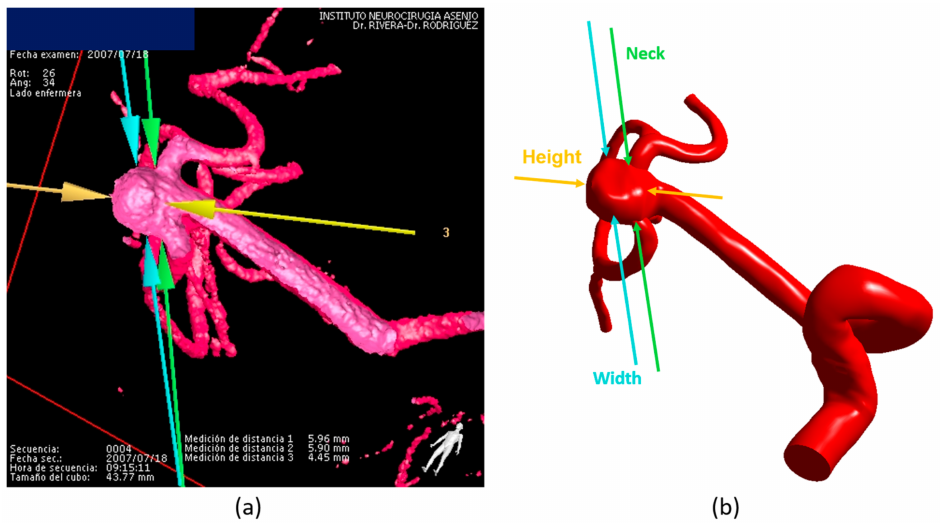
Figure 1. ( a ) 3D angiography image from a patient of the Instituto de Neurocirug í a Asenjo (INCA). ( b ) Computational reconstruction (CAD model) from the angiography image and the geometric dimensions (Neck, Height, Width). The model corresponds to